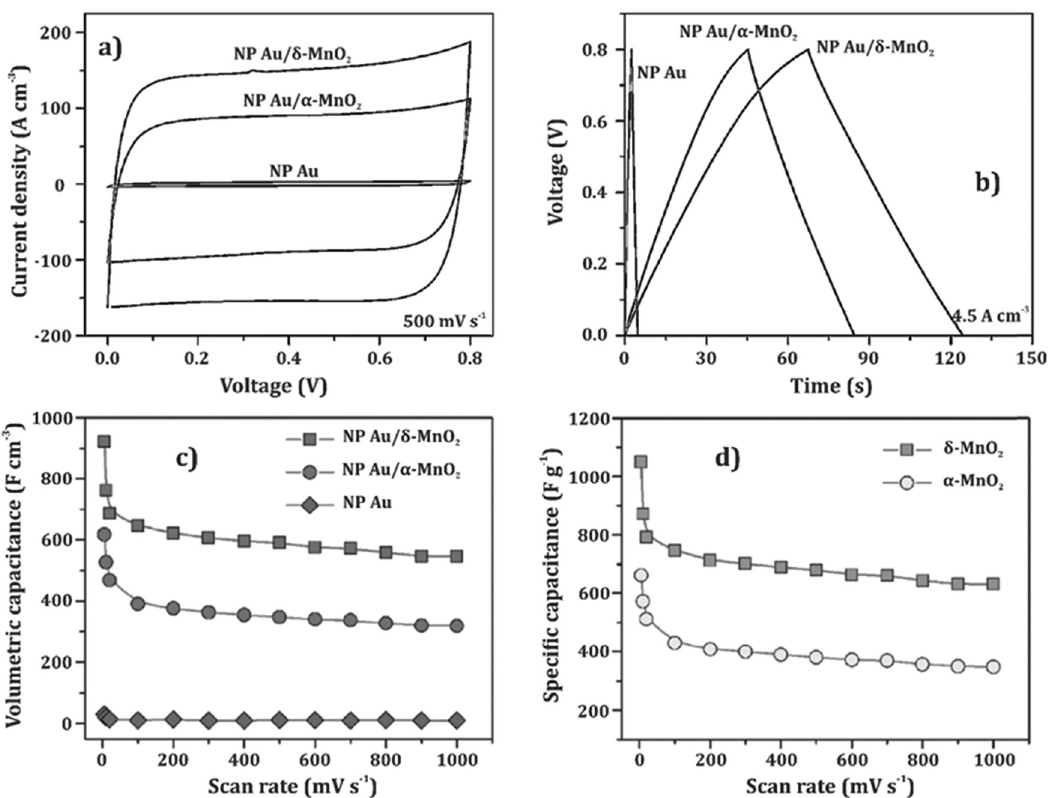
Figure 5: Comparison of the electrochemical behavior between the α - MnO 2 and δ - MnO 2 phases deposited on a gold current collector: ( a ) cyclic voltammetry, ( b ) charge and discharge pro fi les, ( c ) volumetric capacitance, and ( d ) speci fi c capacitance [ 55 ]